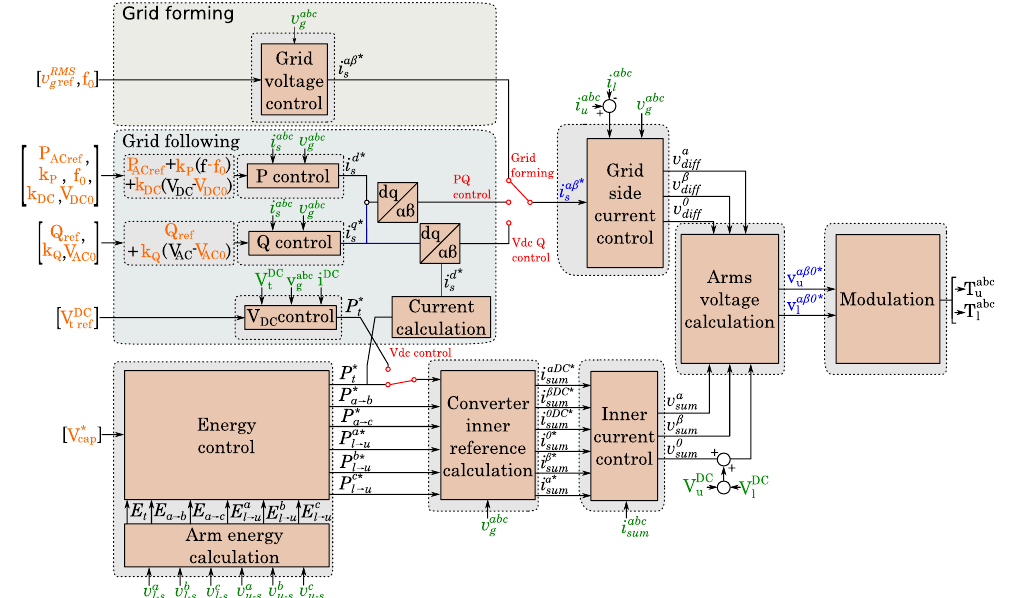
Figure 8. General converter control scheme including grid-forming and grid-following control